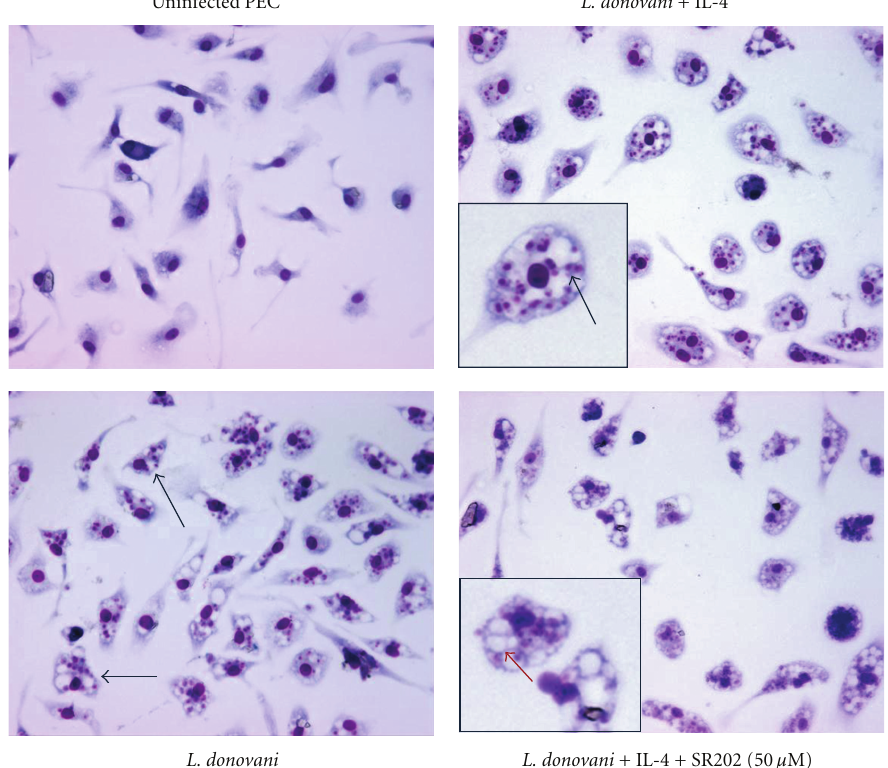
Figure 4: Morphology of the peritoneal macrophages after SR202 treatment. Micrograph of cover slips from the cultures described in Figure 3(b). The black arrows point to macrophages with phagolysosomes filled with amastigotes. The black arrows point to infected macrophages and the red arrow points to infected macrophages with phagolysosomes cleared of amastigotes.